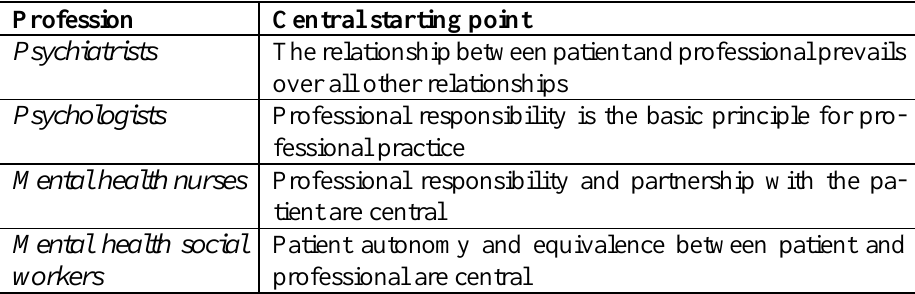
Central starting point for professional practice Profession Central starting point Psychiatrists The relationship between patient and professional prevails over all other relationships Psychologists Professional responsibility is the basic principle for pro- tient are central Patient autonomy and equivalence between patient and workers professional are